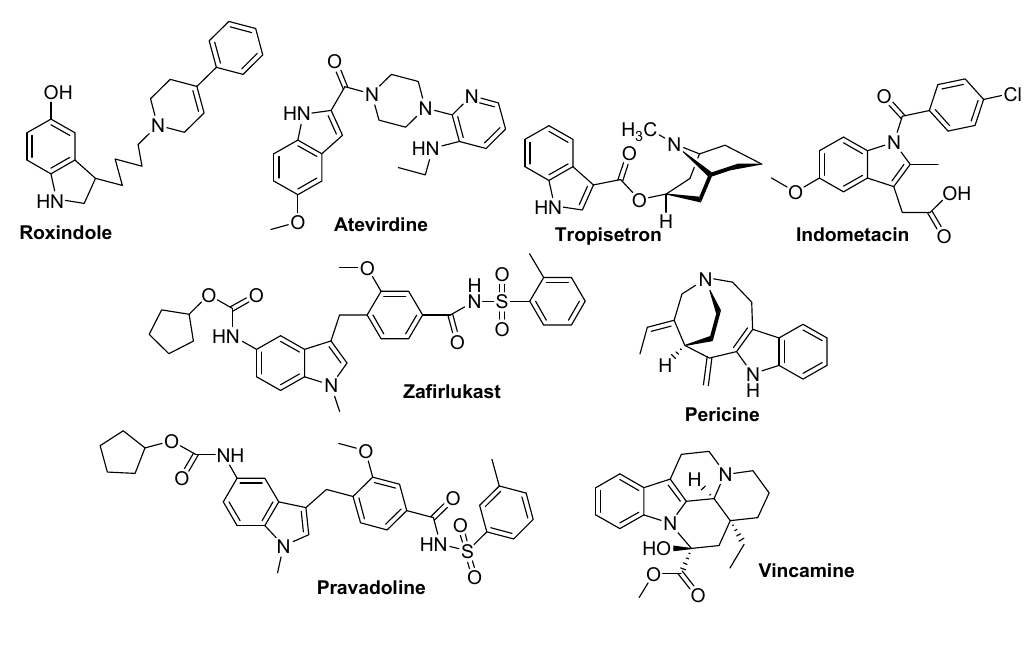
Figure 12. Important indole ring-containing